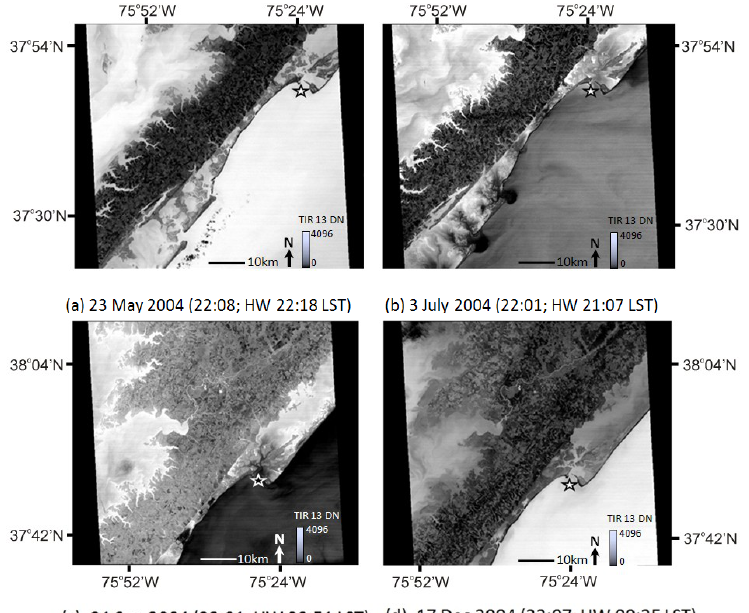
Figure 2. Selected ASTER Quicklooks for band 13 thermal images (60 km swath) used for selection and tidal stage analysis. Location of Chincoteague Inlet highlighted (  ). Image acquisition and nearest high tide (HW) at Chincoteague Inlet Local Standard Time (LST)